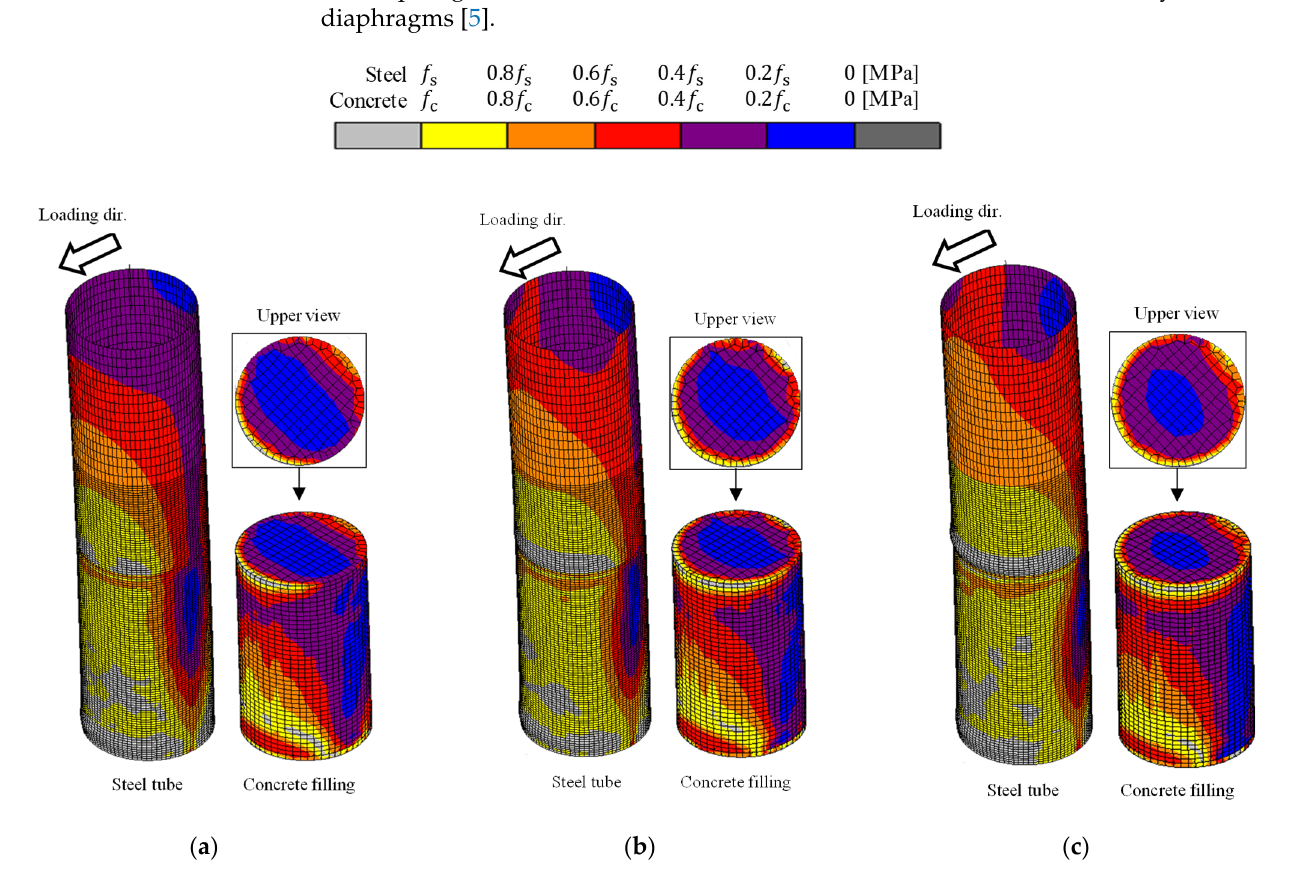
Figure 9. Equivalent stress distribution for steel tube and concrete filling at horizontal displacement of 60 mm (C-009-030, 𝐿 (cid:2913) /𝐿 = 0.4): ( a ) n = 0.1; ( b ) n = 0.2; ( c ) n = 0.3.